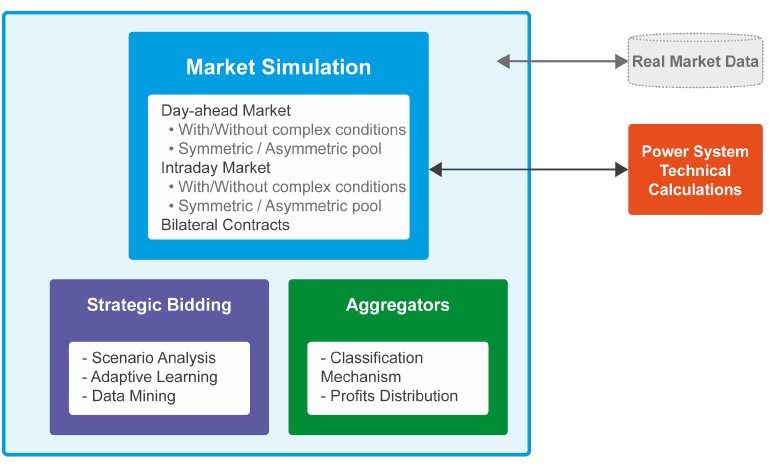
Figure 1. MASCEM’s main features, adapted from